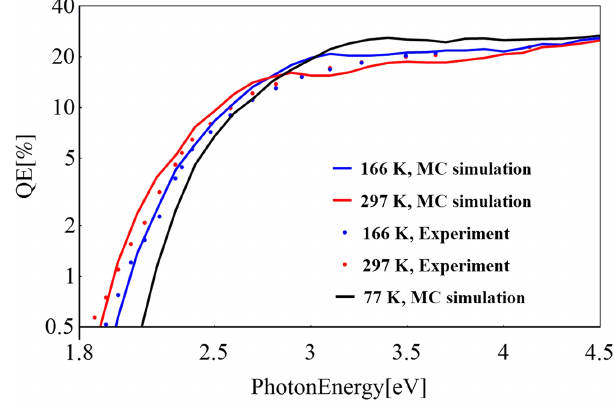
FIG. 11. Simulated spectral response of the bialkali photo- cathode at room temperature (297 K), 166 K, and liquid-nitrogen temperature (solid lines) and experimental data at room temper- ature (297 K) and 166 K